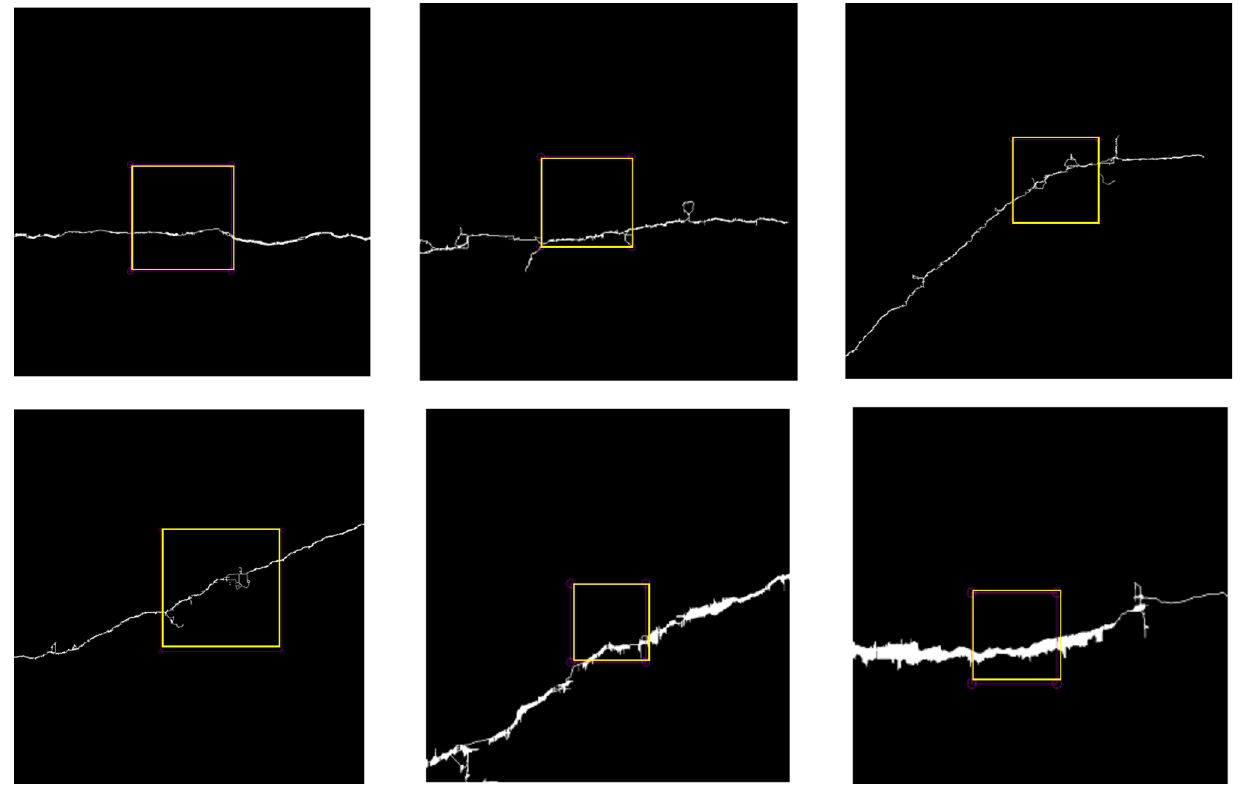
Figure 8. Crack image after binary